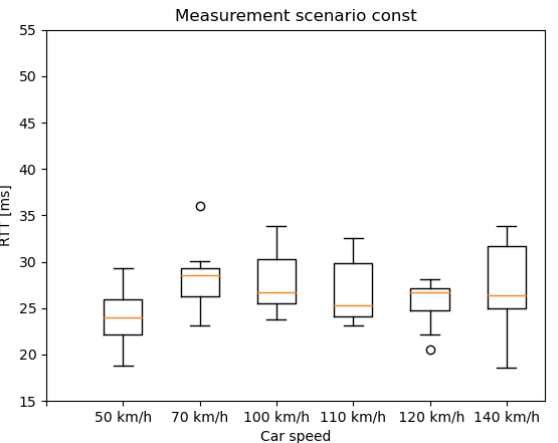
Figure 22. Latency results of the constant packet length and IAT measurement scenario.